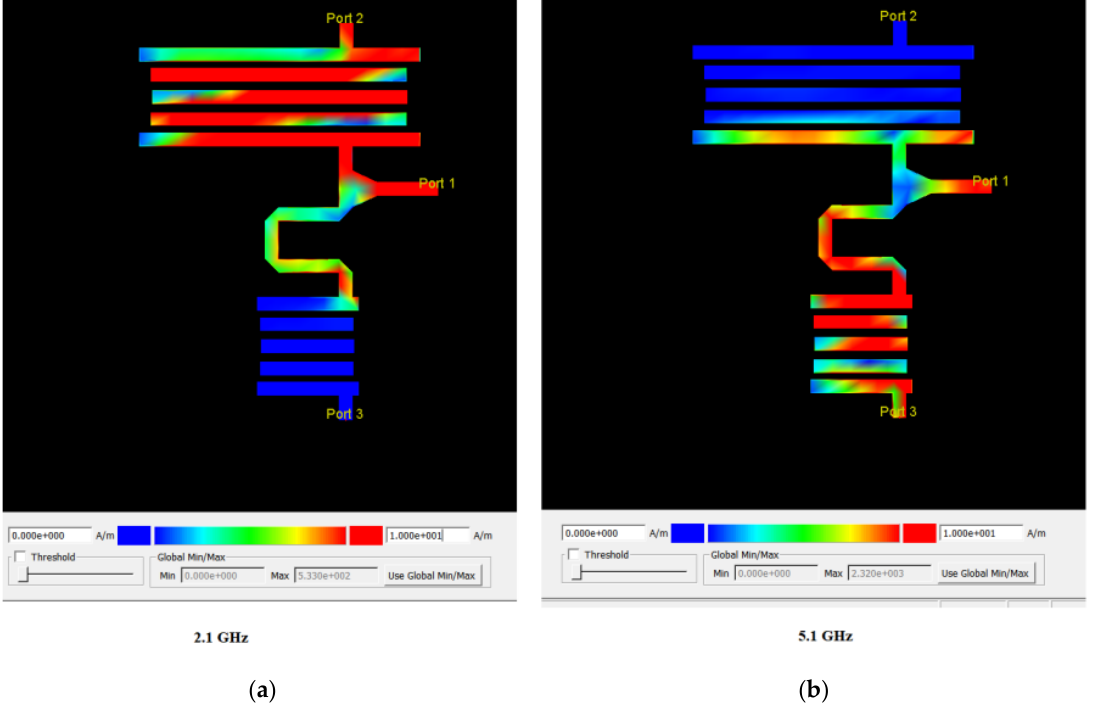
2.1 GHz frequency, which shows that the currents have not reached port 3.